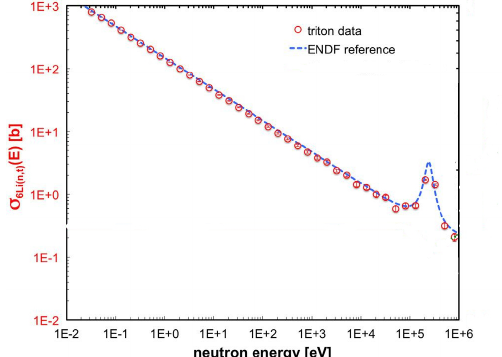
Figure 5. The 6 Li(n, t) 4 He cross-section (circles) measured during the validation test, compared with the international standard (dashed line)